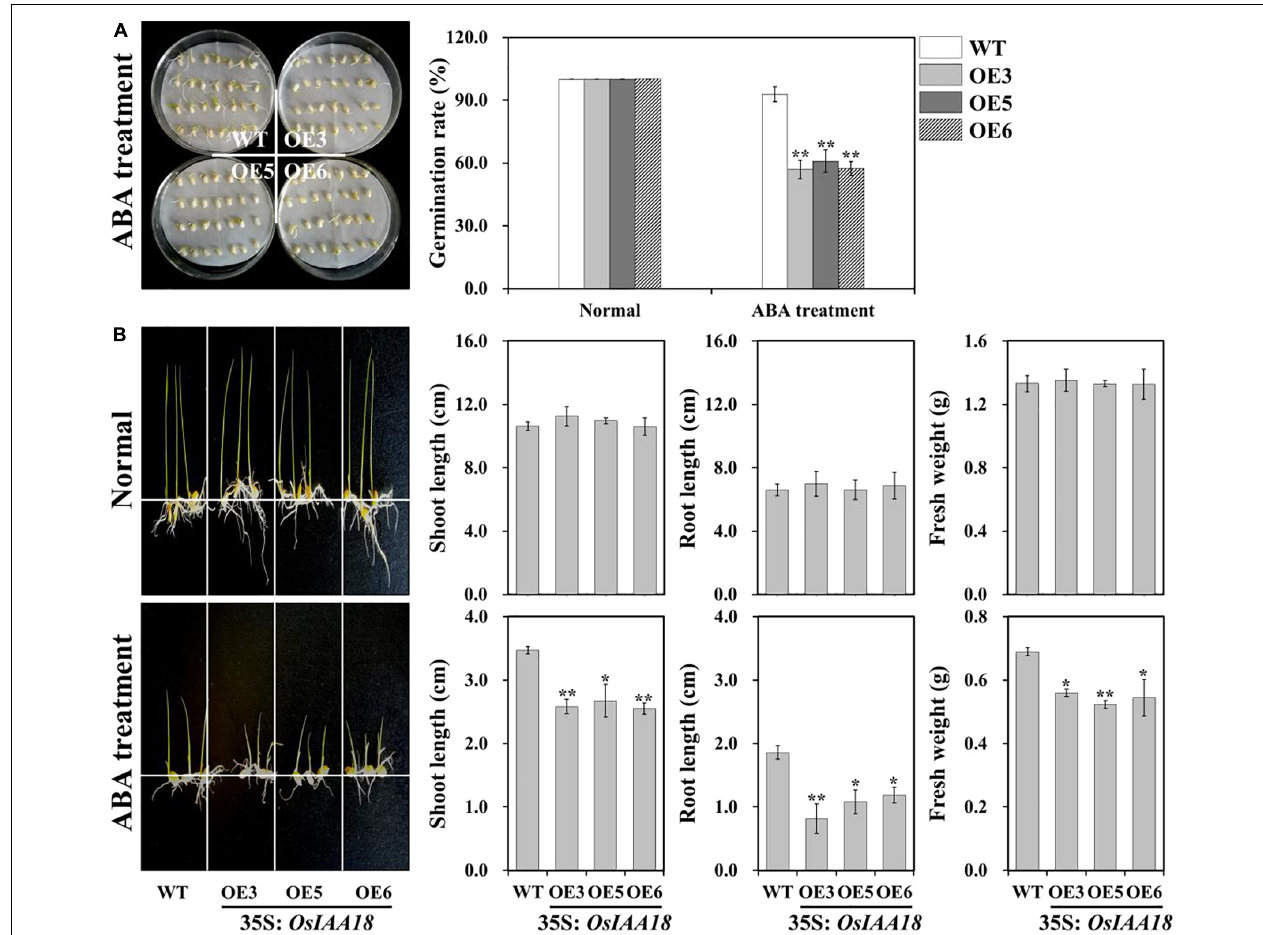
FIGURE 5 | Increased ABA sensitivity of overexpressing OsIAA18 rice plants during germination and seedling stages. (A) Germination assay of OsIAA18 overexpression and WT seeds in 1/2 MS medium with 2.5 µ M ABA. The germination rates of the treated seeds were calculated after 5 days. (B) Growth performance of overexpressing OsIAA18 and WT plants grown in 1/2 MS medium containing 0 and 2.5 µ M ABA. Shoot and root lengths and fresh weight measurements of the rice plants are shown in panel. Data are presented as means ± SE ( n = 3). The values of * and ** indicate a significant difference from that of WT at P < 0.05 and < 0.01, respectively, by Student’s t